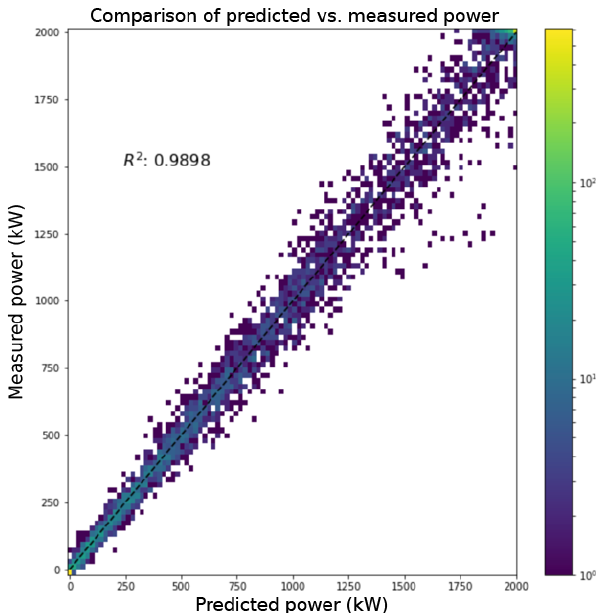
Figure 9. Scatterplot of the measured mean power at the Shagaya wind farm compared to the random forest predicted mean, with the black line indicating a linear fit with a R 2 of